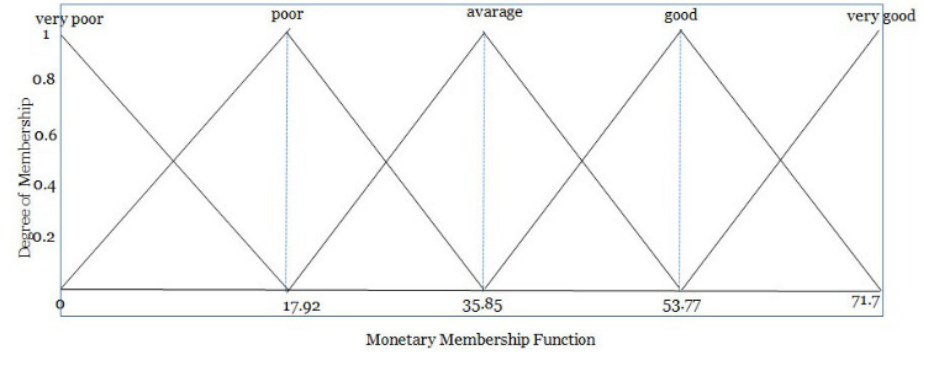
Figure 6. Interval values for monetary membership